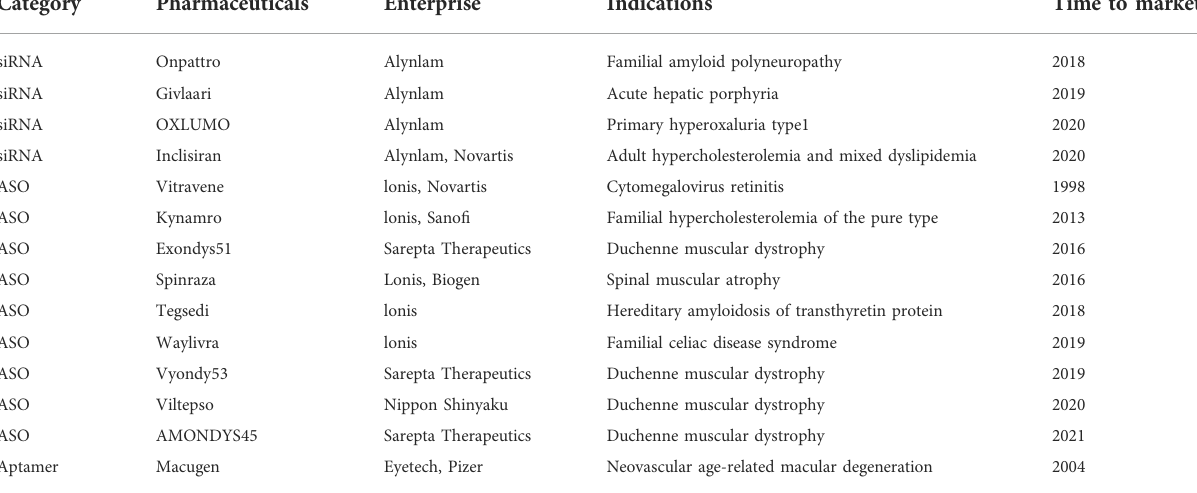
TABLE 3 List of global marketed small nucleic acid